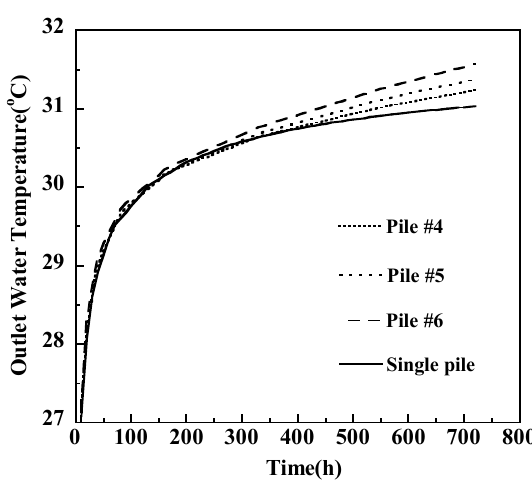
Figure 9. Outlet water temperature variation of Piles #1, #2, and #3 in the quincuncial arrangement and the single pile.